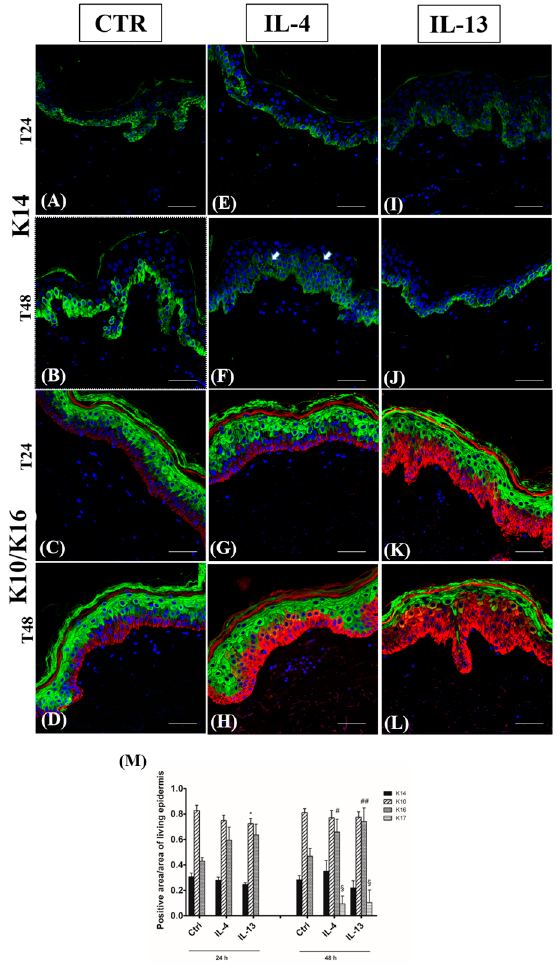
Figure 9. K14 and K10/K16 qualitative and quantitative immunofluorescence analysis. Representa- tive K14 ( A , B , E , F , I , J ) and K10/K16 ( C , D , G , H , K , L ) qualitative immunostainings, and ( M ) quantitative analysis in normal human skin paraffin sections. Green staining for K10 and red staining for K16. ( A , C , E , G , I , K ): samples harvested at 24 h; ( B , D , F , H , J , L ): samples harvested at 48 h. ( A – D ): CTR samples; ( E – H ): IL-4-treated samples; ( I – L ): IL-13-treated samples. ( M ) Quantitative analysis of K14-, K10-, K16-, and K17-positive areas in normal human skin paraffin sections. Results are expressed as the ratio positive area/area of living epidermis + 1 SD; bars indicate standard error. * p < 0.05 vs. all CTR samples; # p < 0.01 vs. all CTR samples; ## p < 0.005 vs. all CTR samples, § p < 0.001 vs. all CTR samples (Kruskal–Wallis analysis of variance followed by Dunn’s post-hoc test). Nuclei are counterstained with DAPI. K14: keratin 14; K10: keratin 10; K16: keratin 16; K17: keratin 17; CTR: control; IL-4: interleukin 4; IL-13: interleukin 13; DAPI: 4 ′ , 6-diamidino-2-phenylindoledihydrochlo- ride. Arrowheads indicate the lower spinous layer. White dotted line indicates the basal mem- brane—scale bars: 50 μ m.